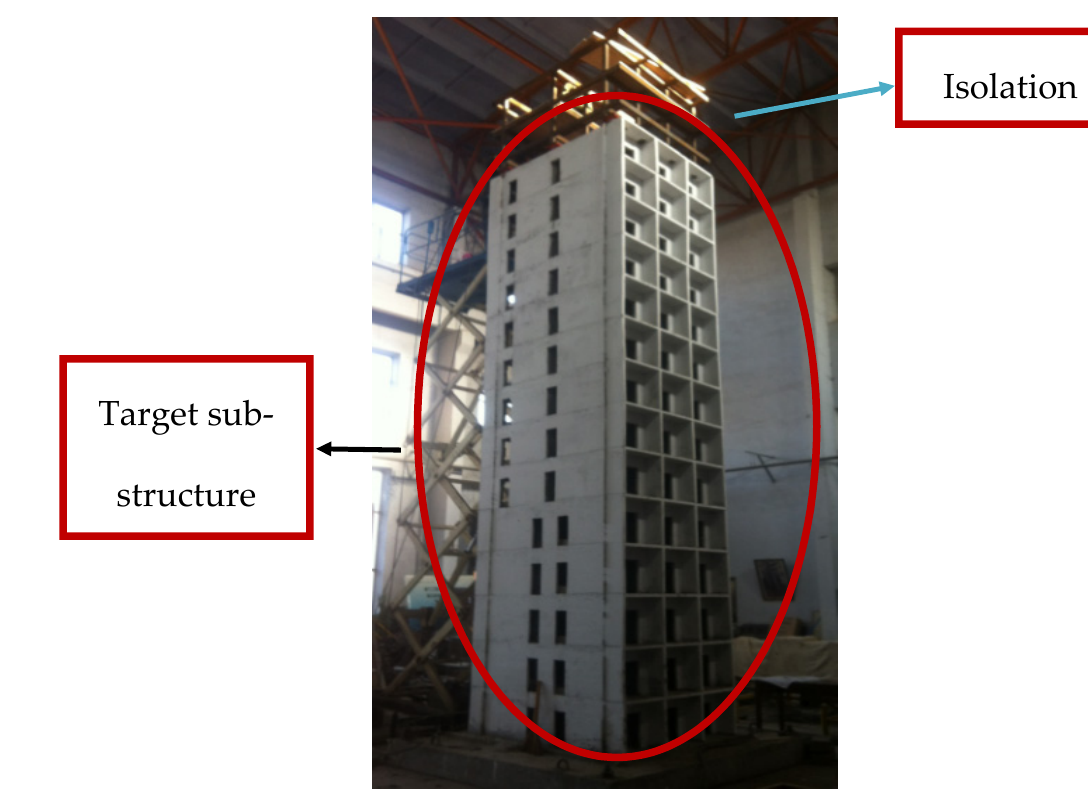
Figure 12. Shear wall building model on the shaking table. Table 3. Similarity ratio between the model and real